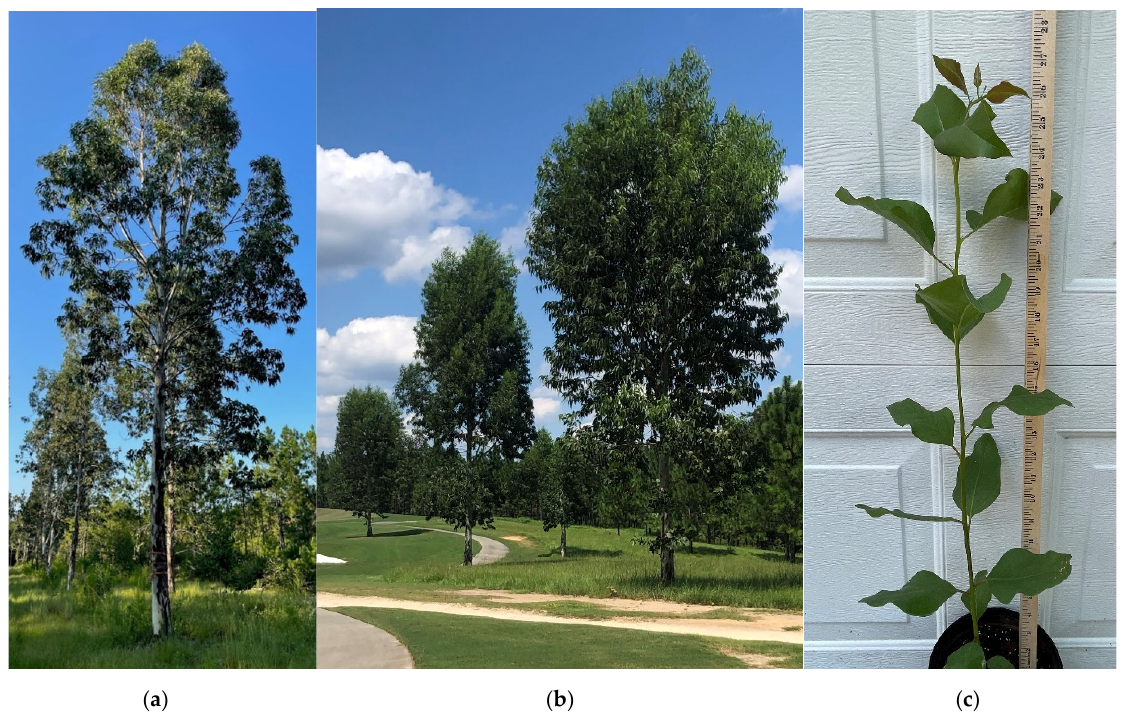
Figure 2. Cultivar A1 in seed orchard AO13 at seven years ( a ), 6-year-old A1 clones ( b ), and 4-month-old A1 open-pollinated seedling ( c ). Table 3. Number of accessions assessed and mean, maximum, and minimum breeding values (%, + or – indicates best, where % indicates positive or negative percentage deviation from the checklot least square mean) for Eucalyptus amplifolia and Corymbia torelliana by